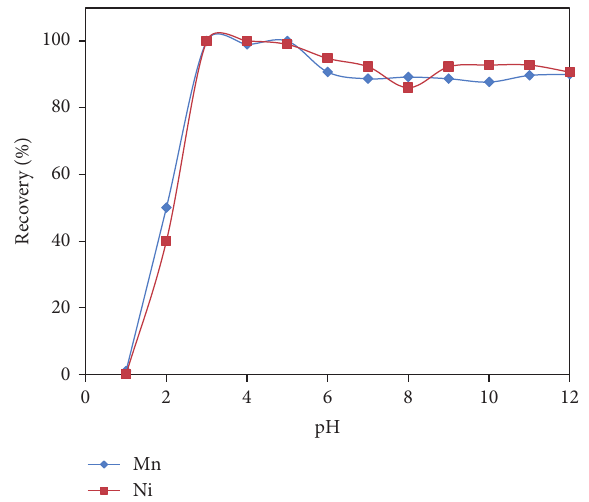
F 1: Effect of pH on the adsorption of Ni (II) and Mn (II) on Schiff base-coated silica-gel. Concentration of standard solution Mn